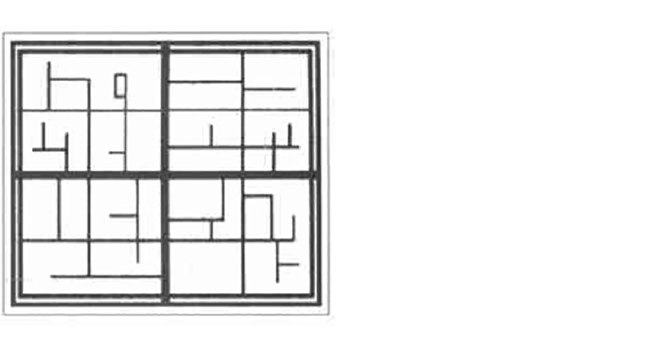
Figure 7. Assumed diagram of the internal street skeleton of the lanes in Chang’an of the Tang Dynasty from Hui and Jiang: Analysis on the Internal Structure of Fangli Units of Chang’an in Tang Dynasty, City Planning Review, 2003 (10), pp. 66–71.